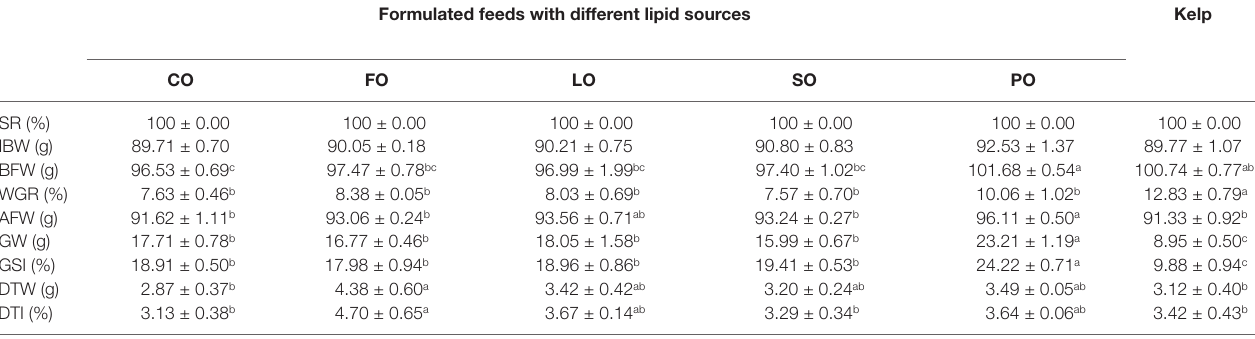
TABLE 4 | Effects of different lipid sources on survival and growth performance of female adult sea urchin ( Strongylocentrotus intermedius ) (mean ± SEM, n=3) 1 . Formulated feeds with different lipid sources